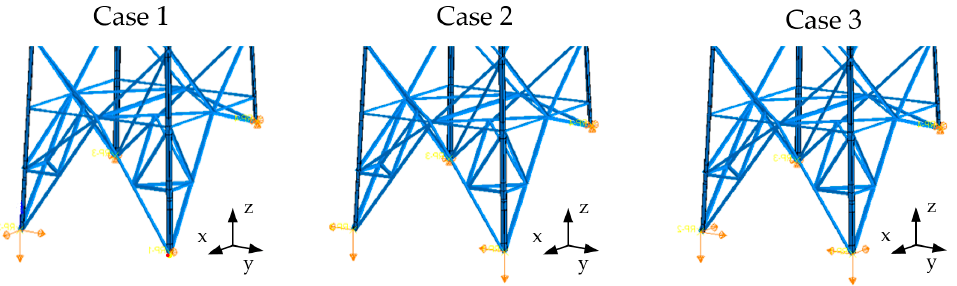
Figure 24. Support movement direction and magnitude for every analyzed case. In Case 1, a single leg was moved in x+ and y+ directions (positive displacements) and z- (negative disp.); in Case 2, two legs were moved in y- and z- directions (negative disp.); in Case 3, two legs were moved in x-, y- and z- directions (negative displacement). No support, including the ones that did not move, allowed rotation in any axis.